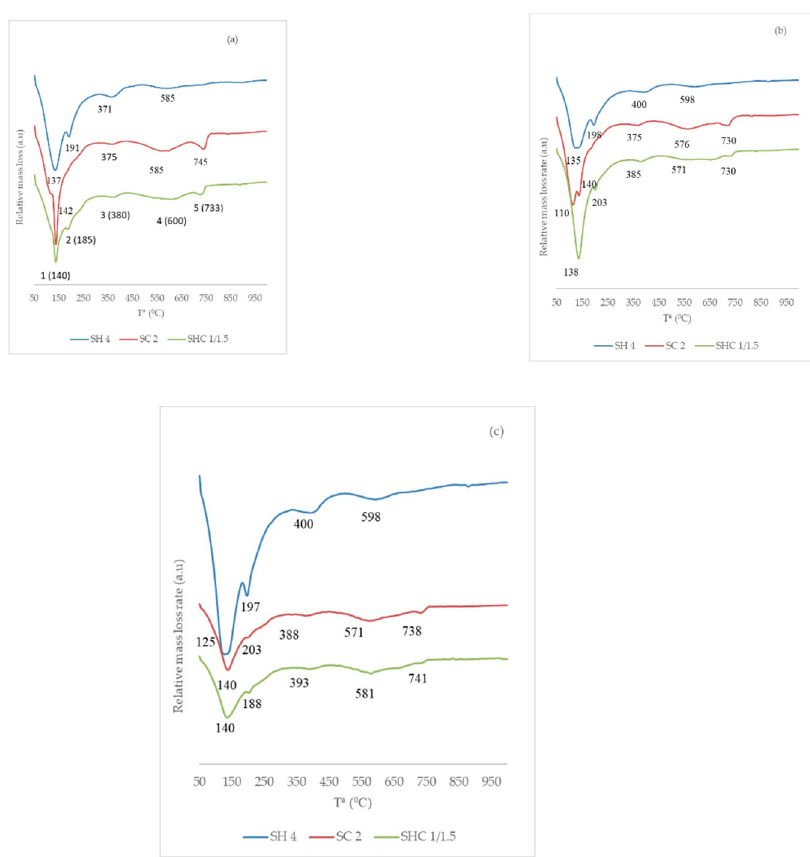
Figure 7. DTG curves of the pastes cured for: ( a ) 7 days; ( b ) 28 days; ( c ) 90 days.